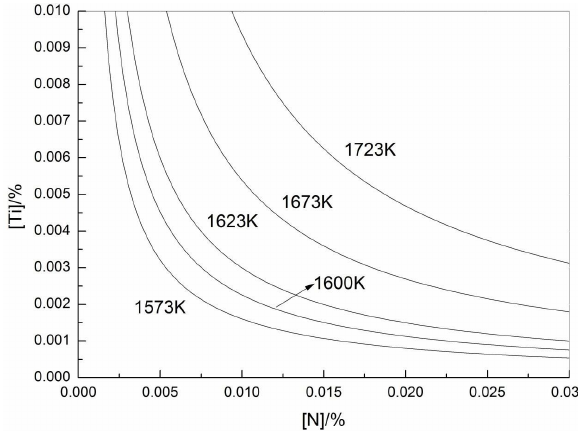
Figure 11: The balance between N and Ti in steel-liquid within the range of solidification temperatures